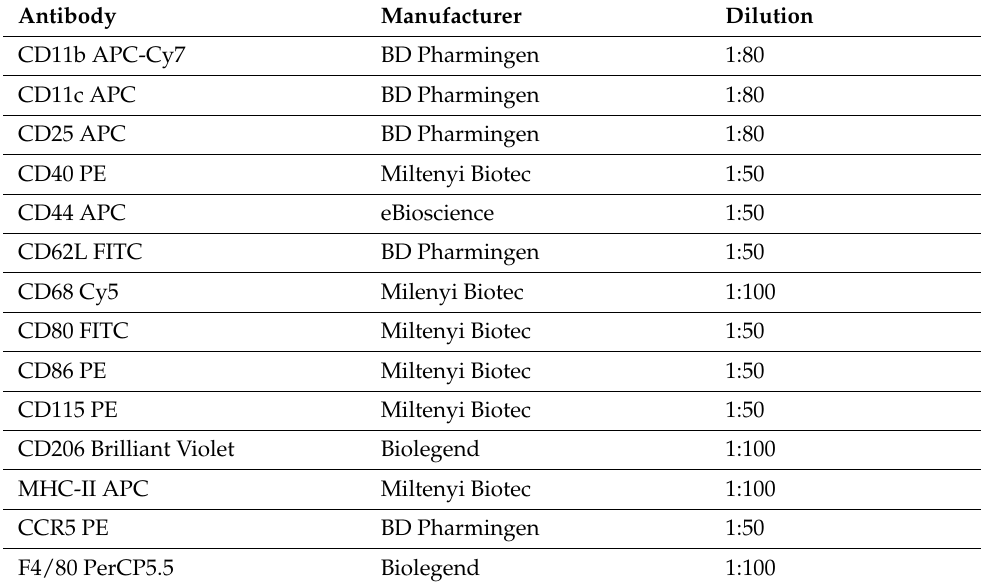
Table 1. Antibodies used for the immunophenotypic characterization of M1 and M2 macrophages obtained from CFA and EAE